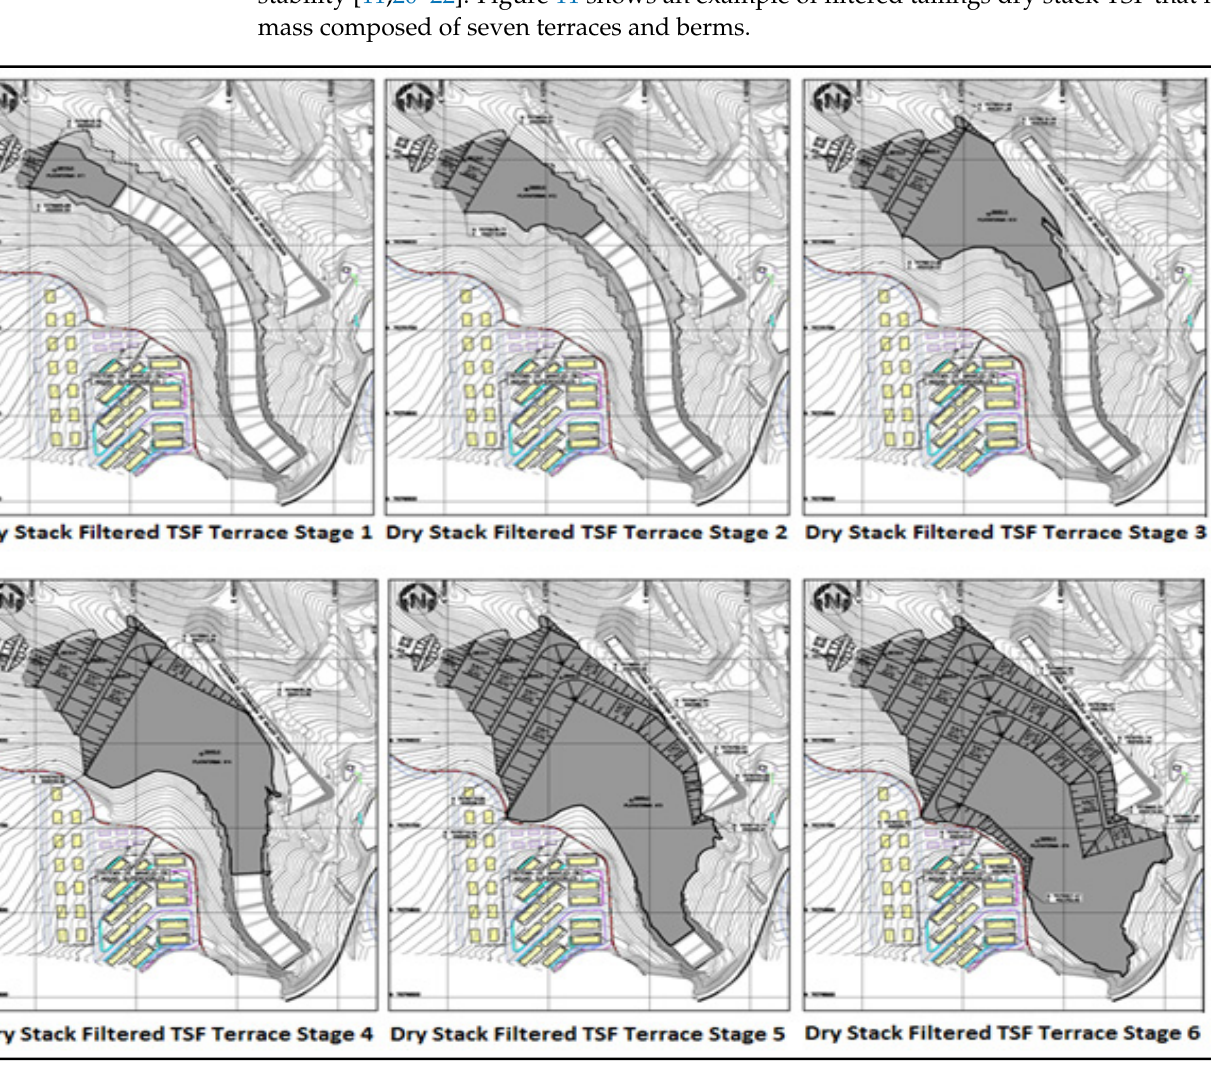
Figure 10. Typical Dry Stack TSF Disposal Scheme and Placement—Layout View [18].